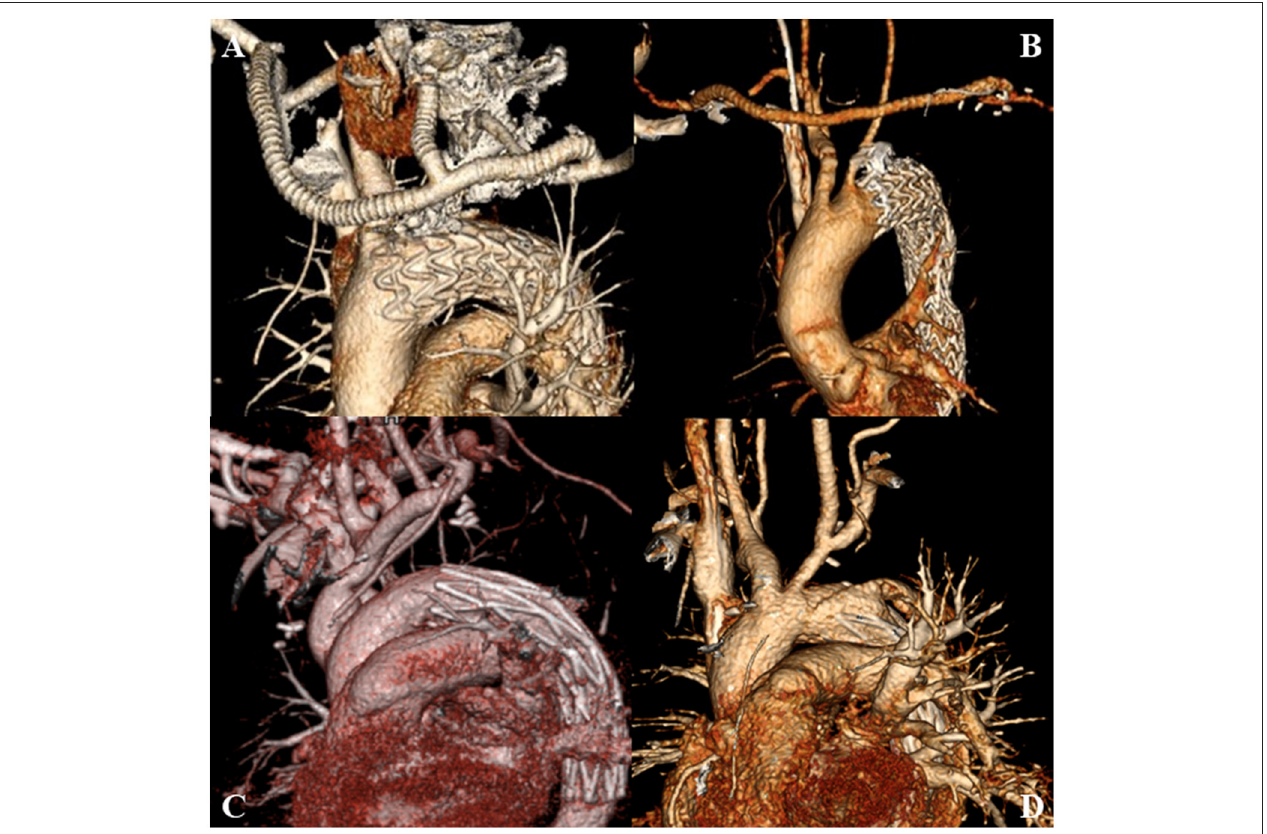
FIGURE 2 | (A) HAR performed in Zone 1; (B) HAR performed in Zone 2; (C) SET performed in Zone 1; (D) SET performed in Zone 2. SET, stent elephant trunk procedure combined with supra-aortic branch reconstruction; HAR, hybrid procedure combined TEVAR with extra-anatomic bypass.